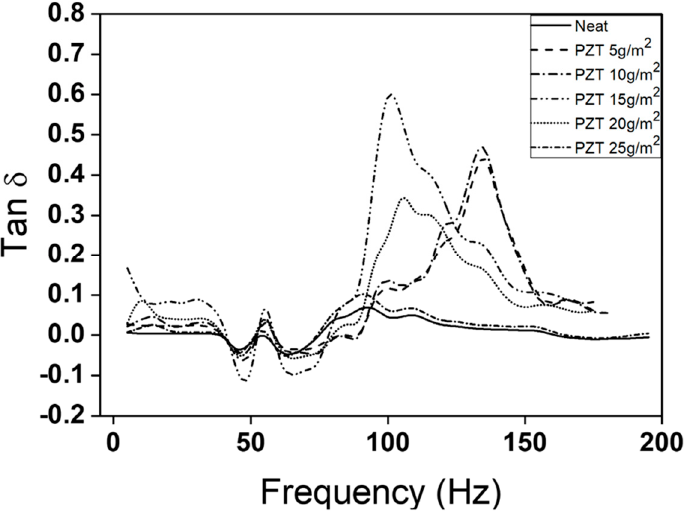
Figure 4. Loss factors of the CFRP specimens with PZT-particle-dispersed mixture films as functions of the frequency. Measurement data for different particle loadings.